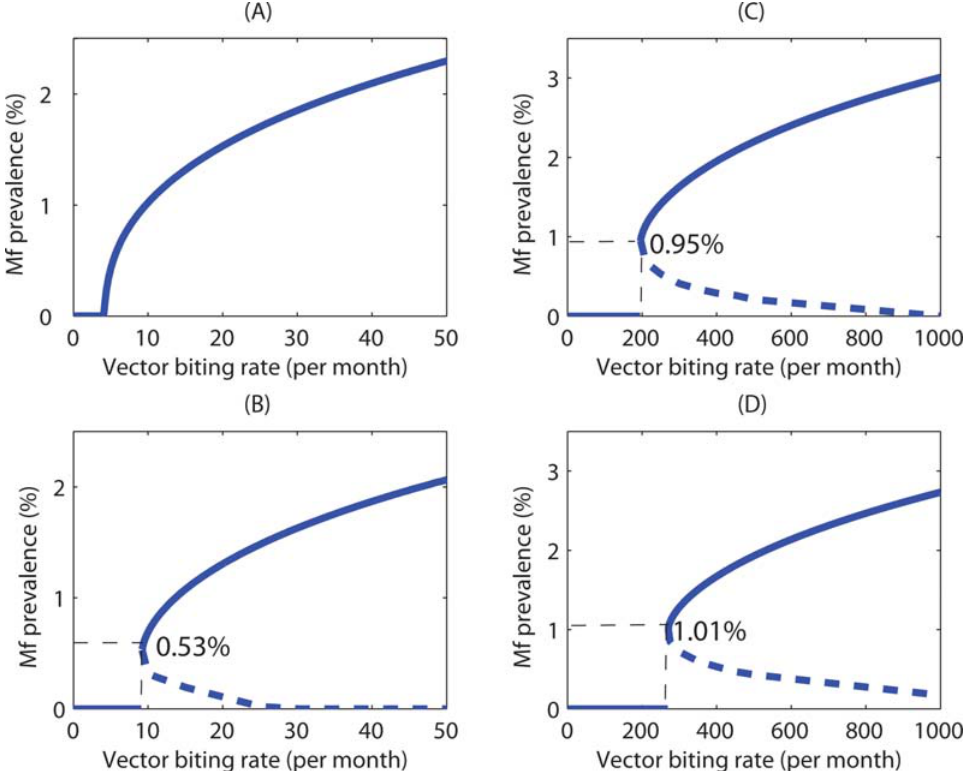
Figure 2. The effect of varying the vector biting rate on the equilibrium Mf prevalence among human hosts when the vector intermediate host was culicine and when the worm mating probability was (A) and was not (B) included in the model, and when the intermediate host was anopheline with (C) no mating and with (D) mating probabilities included. Inclusion of the mating probability introduced a set of breakpoints (dotted line) in the case of Culex , and it raised and increased the range of the breakpoints in the case of Anopheles . The labelled Mf values on the y-axes correspond to the maximum breakpoints, whereas additionally in each graph the solid curve (A) and vertical dashed drop lines (B–D) crossing the x-axes denote the threshold biting rates (TBRs) estimated in each scenario corresponding to A) 4, B) 9, C) 197, D) 271 vector bites per month. the equilibrium endemic level (Fig. 3). The arrows in each figure indicate the directions in which perturbations from the breakpoint will tend to change each system. An indication of the rates of system change for each model from the vicinity of the respective steady state age-Mf prevalence levels is also given by the clustering of the age-curves shown in Figure 3. Where the curves cluster—i.e.